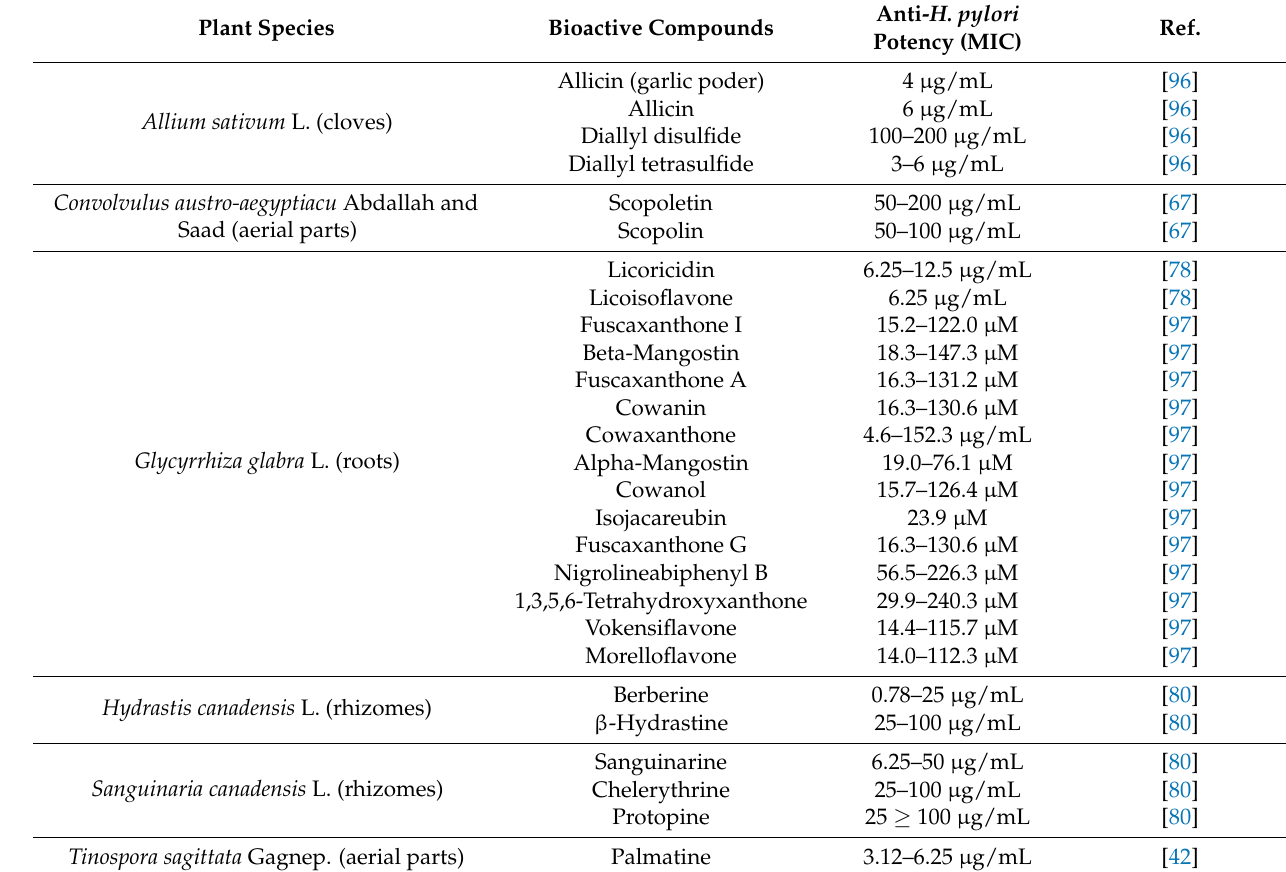
Table 10. Bioactive compounds with anti- H. pylori